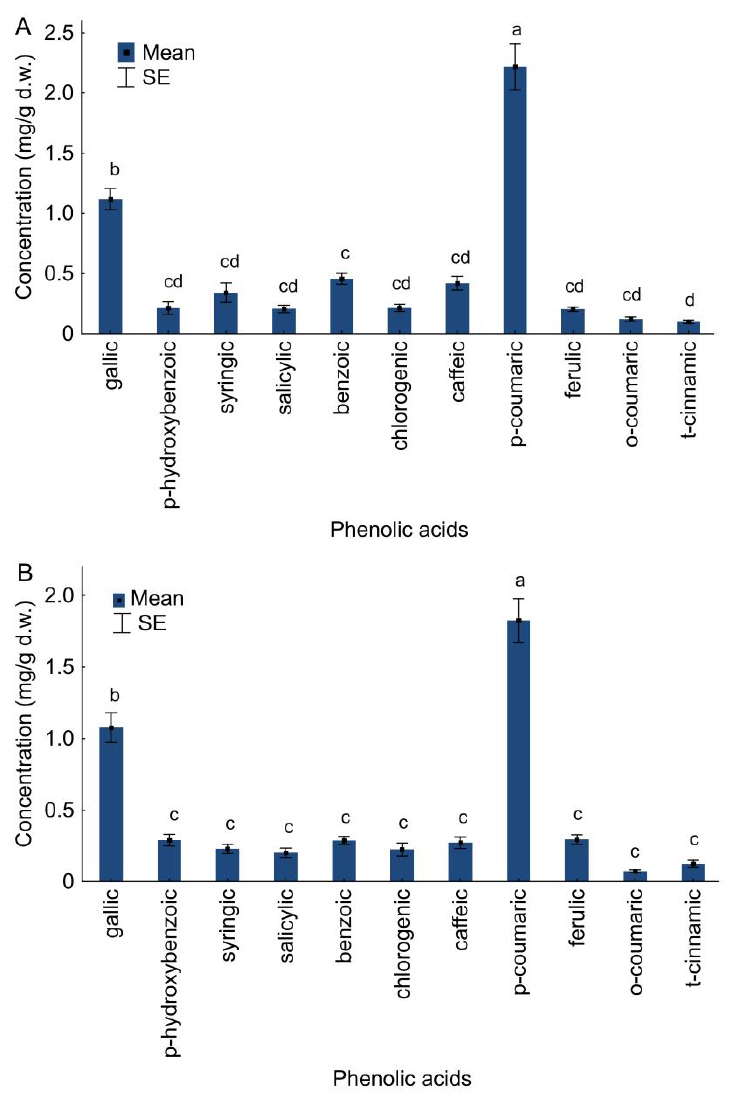
Figure 3. The concentration (mg/g d.w.) of individual phenolic acids in V. opulus variety Roseum ( A ) and wild plants ( B ). Different letters denote significant differences (one–way ANOVA; Tukey’s test; p < 0.05). Table 2. The effects of temperature, place, survey number and interaction between studied